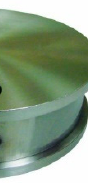
Figure 2. Expansion Cell as per API RP 10B5.